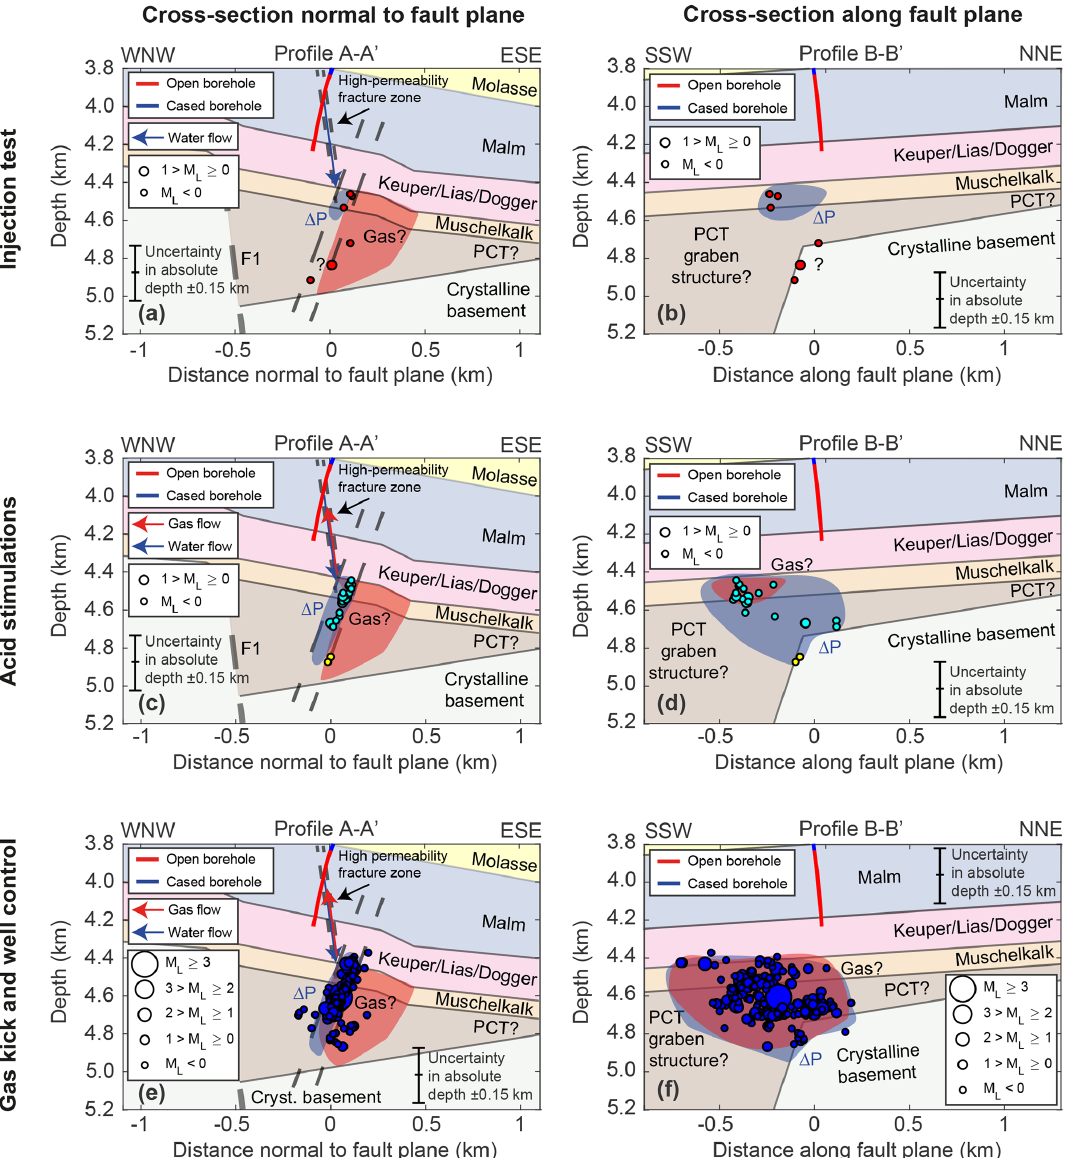
Figure 3. Conceptual model of the stimulation phase, the gas kick, and the well control measures in July 2013. (a, b) Seismicity of the injection test (14 July) on a profile (a) normal to (A–A (cid:48) in Fig. 2) and (b) along (B–B (cid:48) in Fig. 2) the fault. The blue shaded area denotes the region affected by the direct pressurization, while the red shaded area depicts the possible location of the gas as described in the text (shown in all subfigures). The question mark next to the deeper events indicates that their location is probably an artifact that can be removed considering a local v p /v s velocity anomaly (Diehl et al., 2017). (c, d) Seismicity due to the acid stimulations (17 July) on a profile (c) normal to and (d) along the fault. The yellow dots correspond to the seismicity induced during the first acid stimulation, while the cyan dots mark the events induced during the second acid stimulation. The red shaded area in (d) is the region affected by the proposed seal breach through which the gas may have migrated. (e, f) Seismicity during and after the well control measures (19–31 July) on a profile (e) normal to and (f) along the fault. The injected fluid and the gas that is intruding into the fault could have caused the seismic sequence including the M L 3.5 main shock. Depth is defined relative to the top of the borehole (i.e., the free